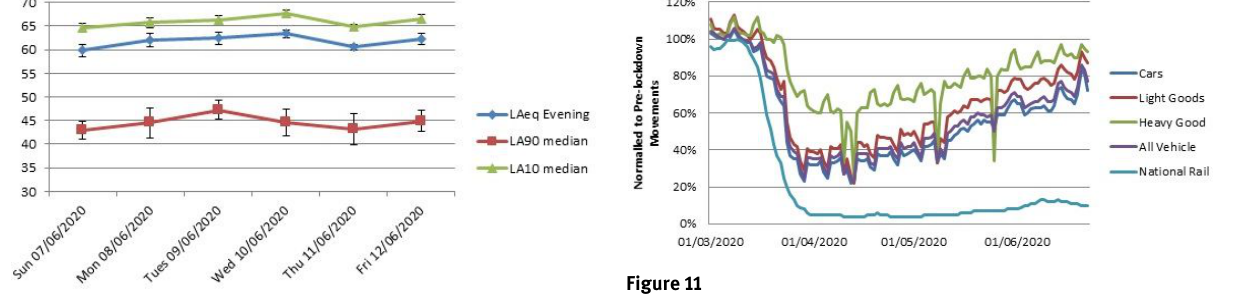
Figure 9: Case Study B: Evening noise levels +/ − 1 standard devia- tion